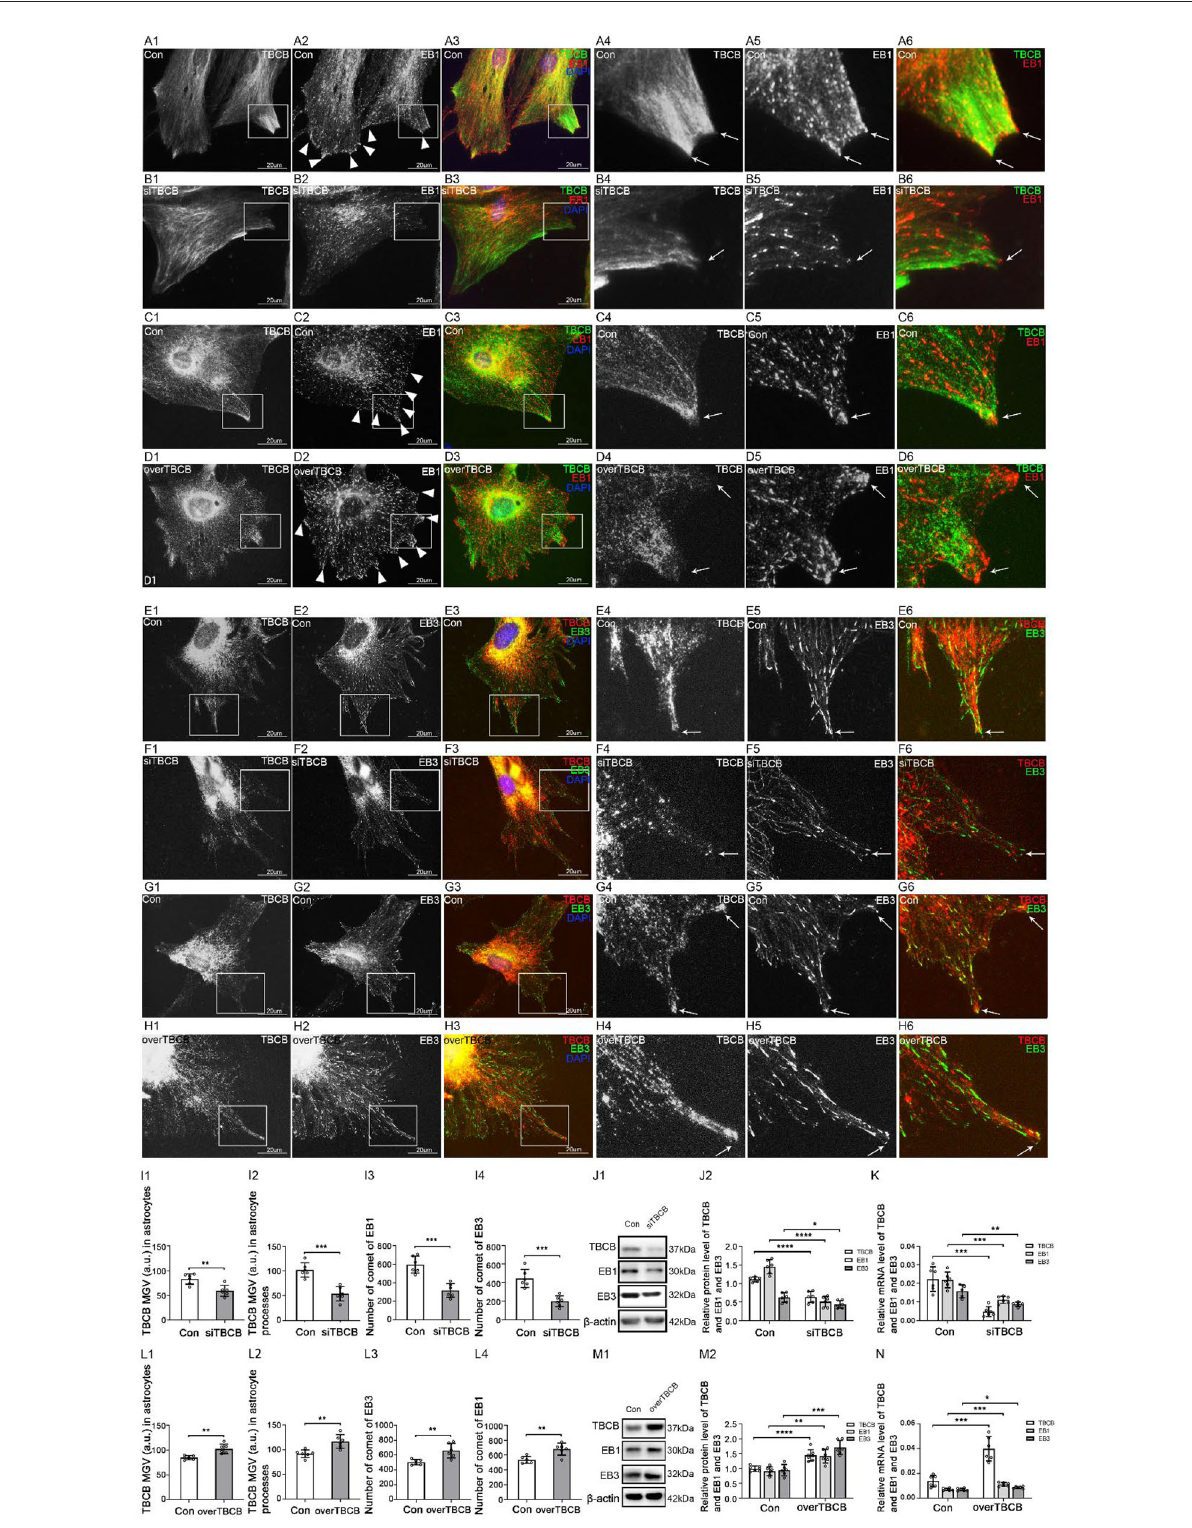
FIGURE7 The expression of EB1/EB3 in astrocytes after TBCB was silenced or overexpressed. (A–H) Immunofluorescence showed that TBCB [ (A–D) green signal; (E–H) red signal] was co-expressed with EB1 [ (A–D) red signal] or EB3 [ (E–H) red signal] in astrocytes both in the control group [Con (A,C,E,G) ] and TBCB silence group (B,F) or TBCB overexpression group (D,H) . (I,L) The mean gray value (MGV) of TBCB in astrocytes and its processes (MGV = Integrated Density/Area) and the number of EB1/EB3 comets after EB1/EB3 was silenced or EB3 was overexpressed. (J,M) Western blot and (K,N) RT-PCR analysis of the levels of EB1/EB3 protein and TBCB protein and its mRNA after TBCB was silenced or overexpressed compared with the control group ( n = 6, p < 0.05). (A–N) Number of panels. * p < 0.05, ** p < 0.01, *** p < 0.001, **** p <